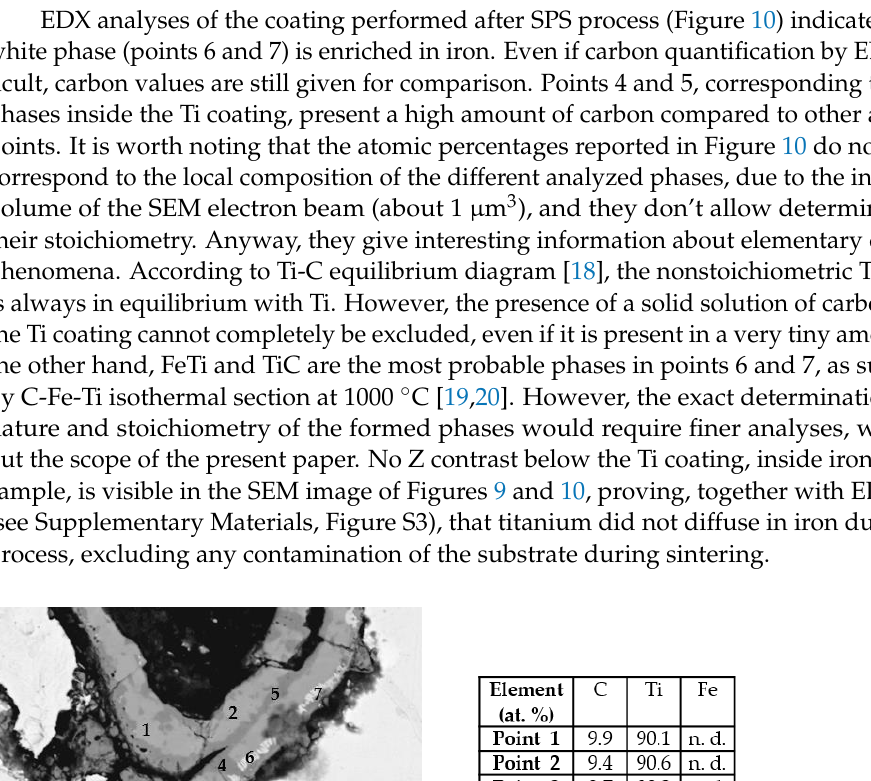
Figure 9. Magnification of the interface between the sintered sample and the graphite foil coated with a Ti PVD layer of 1.5 µm thickness.